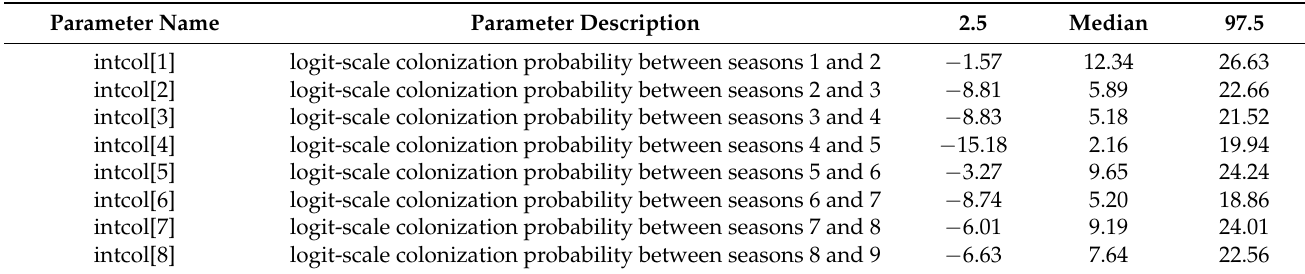
Table 5. Median along with 2.5% and 97.5% quantiles for posterior probability distributions of derived parameters from fitting an auto-logistic parameterization of a dynamic occupancy model to presence/absence data of juvenile blue crabs Callinectes sapidus across ten seasons in eight North Carolina (USA) tidal creeks. See Supplementary Material S1 for model